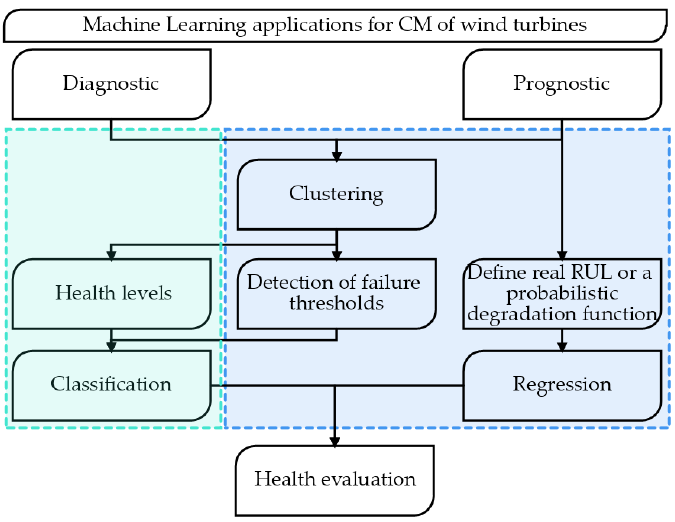
Figure 4. Machine learning application for condition monitoring.